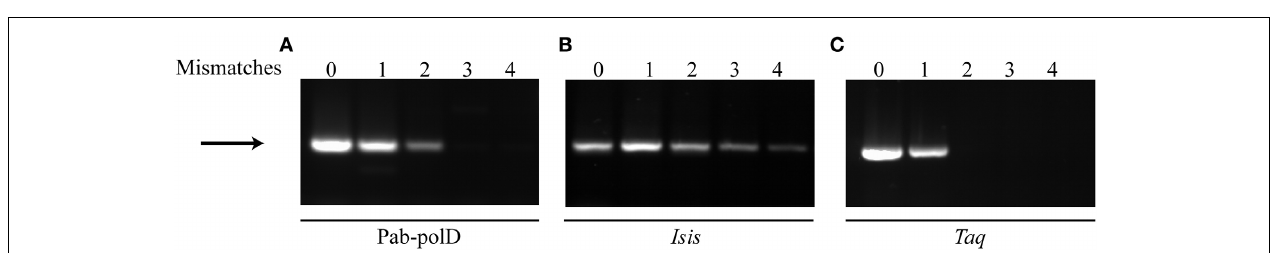
FIGURE 5 | PCR amplification of DNA fragments of various lengths. PCR reactions were carried out using 100ng of genomic DNA with 0.1 Uof Pab-polD (A) , 1 U of Pab-polB (B) , and 1 U of Taq-polA (C) in their respective reaction buffer ( Table 2 ). Primer sets were chosen to amplify 0.5, 1.1, 1.95,